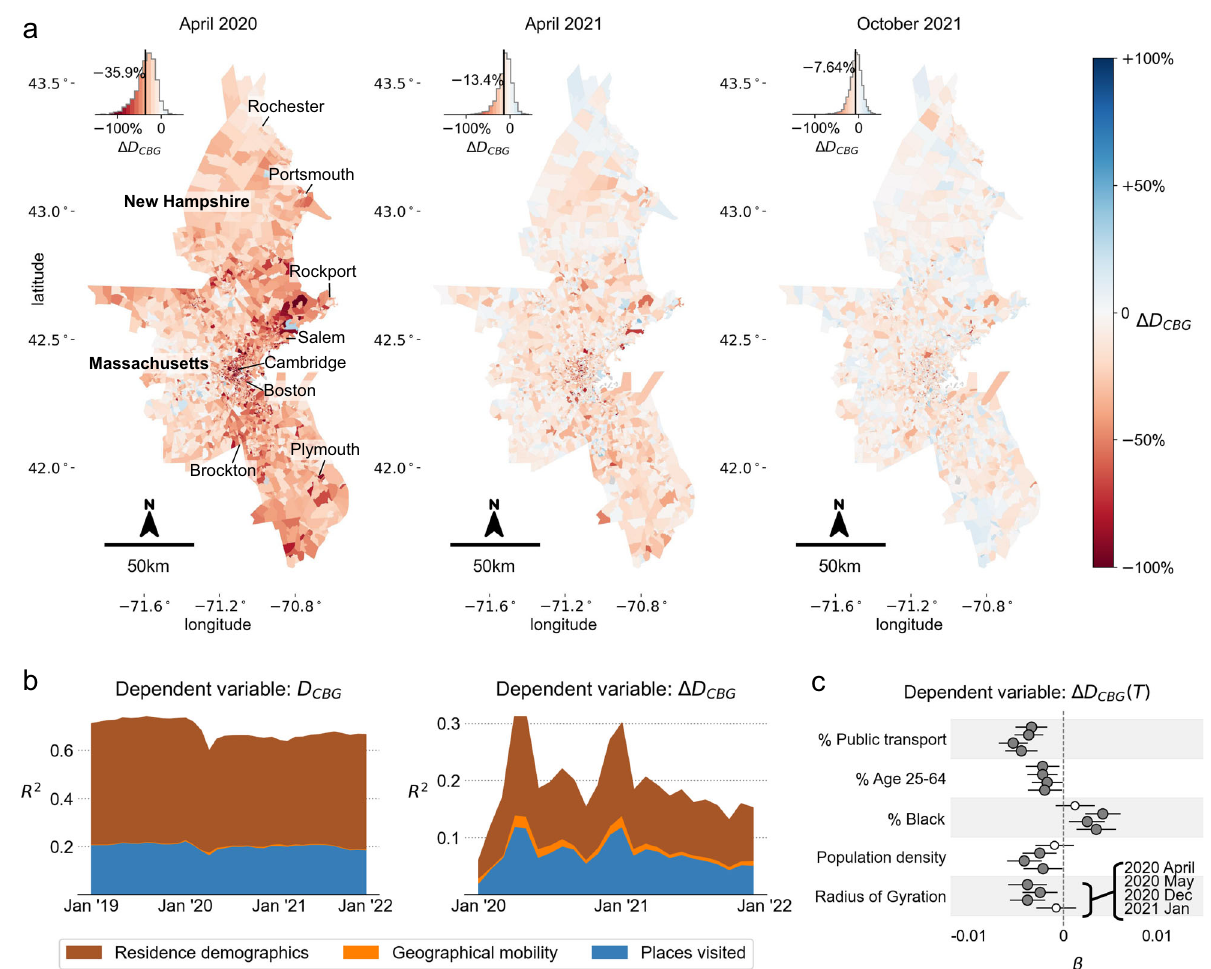
Fig.3|Spatialandsocioeconomicheterogeneityindecreaseddiversity.a Maps show changes in mean experienced income diversity on the census block group (CBG) levels in the Boston CBSA for three different time periods (April 2020, April 2021,andOctober2021),comparedwiththecorrespondingmonthsin2019.Insets showhistogramsofdifferencesinexperiencedincomediversity Δ D CBG . b Adjusted R 2 of regression models for D CBG and Δ D CBG , respectively, across different time periods. The three groups of variables (places visited, geographical mobility, and residence and demographics) explain around 55% to 70% of the variance in experienced income diversity. However, the same variables explain a much lower variance of Δ D CBG , indicating that regions became less diverse homogeneously.